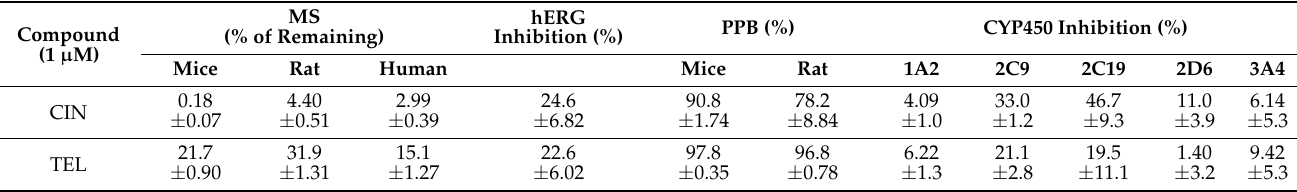
Figure 3. Anti-SARS-CoV and anti-SARS-CoV-2 activity of digitoxin, bufalin, cinobufagin, telocinobufagin, bufotalin, cinobufotalin, and resibufogenin. The dose–response curve analysis using immunofluorescence staining was performed to determine the anti-SARS-CoV ( A ) and anti-SARS-CoV-2 ( B ) activity of cardiotonic steroids in Vero cells (ranging between 0.001 and 10 µ M). Inhibition of SARS-CoV and SARS-CoV-2 infection (%, blue circles) and cell viability (%, red squares) were indicated. IC 50 values were calculated using non-linear regression analysis. The data represent duplicate experiments and are presented as the mean ± SEM. Table 1. Microsomal stability (MS), hERG inhibition (10 µ M), plasma protein binding (PPB), and CYP450 inhibition (10 µ M) of cinobufagin (CIN) and telocinobufagin